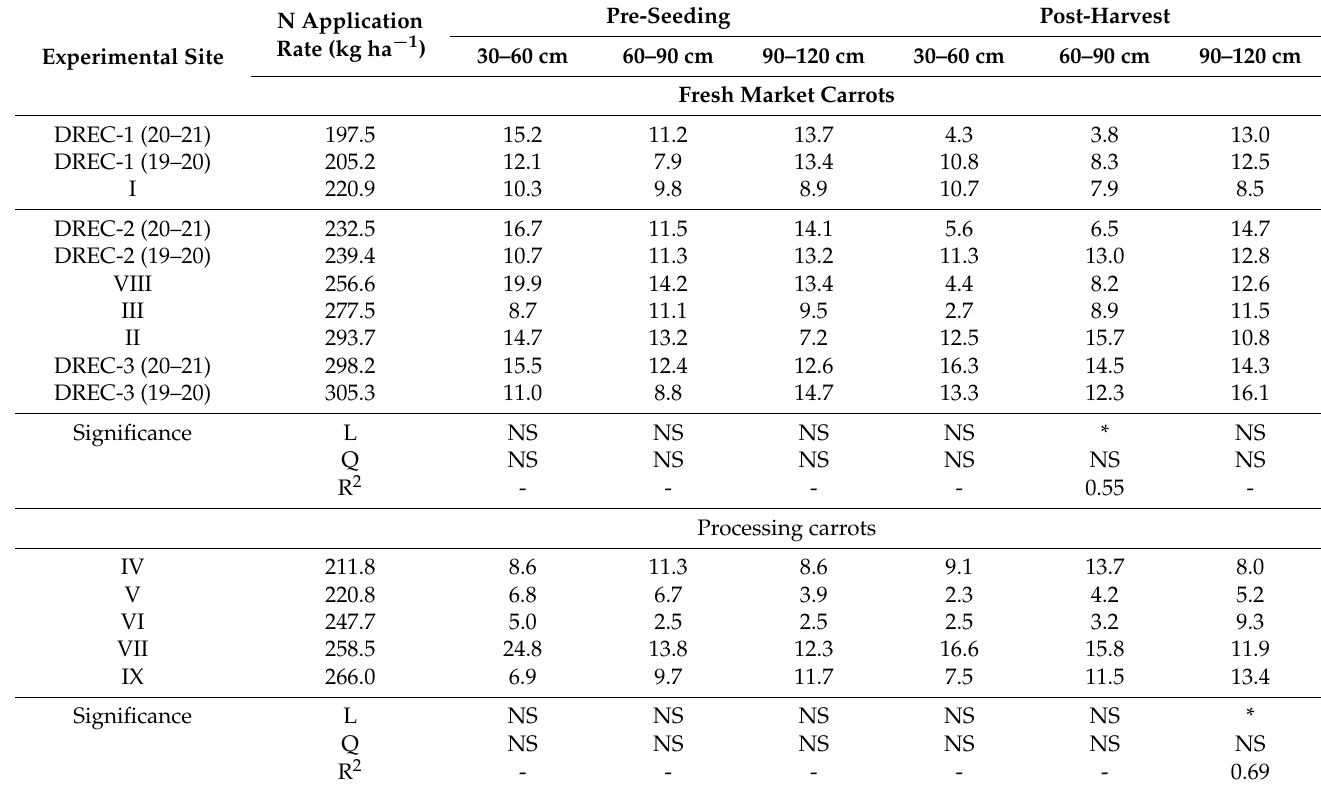
Table 5. Effect of N application rates on NO 3 -N concentrations (mg kg − 1 ) in fresh market and processing carrots pre-seeding and post-harvest at various